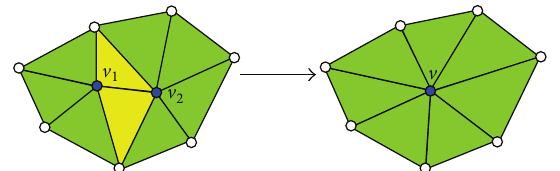
Figure 2: Surface simplification using quadric error metrics